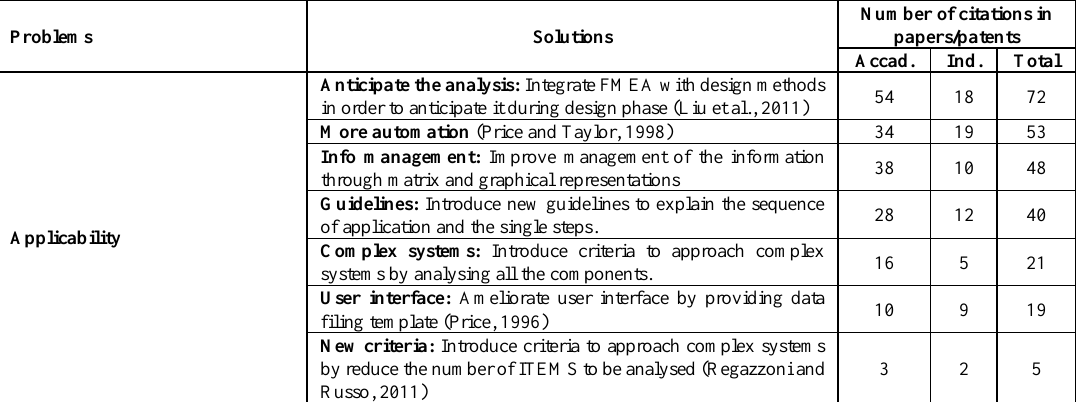
Table 4. Main problems and solutions to improve FMEA, from Spreafico et al.